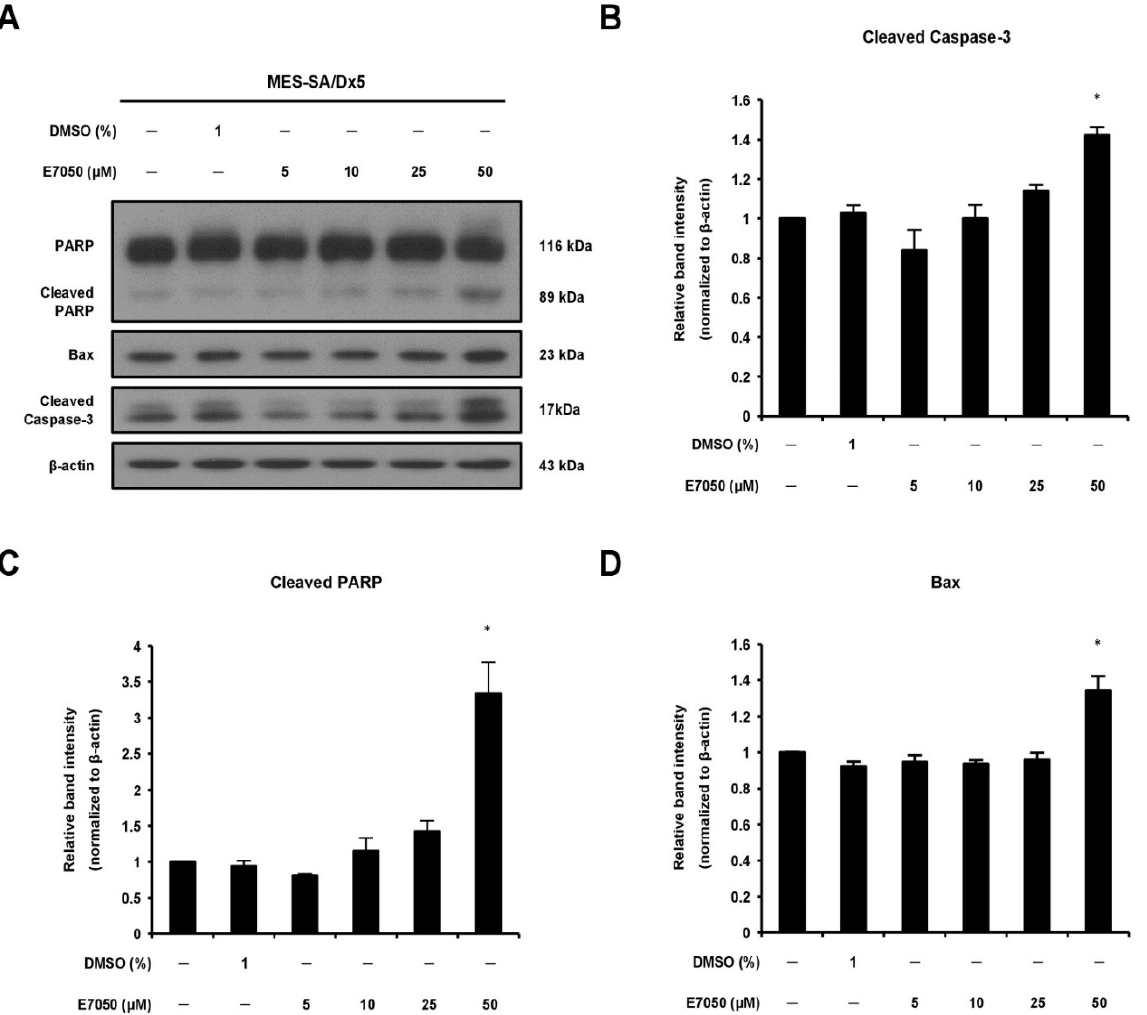
Figure 2. Effects of E7050 on the expression of apoptosis-related proteins in MES-SA/Dx5 cells. ( A ) Cells were treated with E7050 at various concentrations (5–50 µM) for 24 h. Cellular extracts were prepared and subjected to Western blotting with specific antibodies which recognized PARP, cleaved PARP, cleaved caspase-3, Bax and β -actin. β -actin was used as an internal loading control. The relative protein levels of ( B ) cleaved caspase-3, ( C ) cleaved PARP and ( D ) Bax were quantified by densitometry and normalized to β -actin. Data are presented as the mean ± SEM of three independent experiments. * p < 0.05 versus vehicle-treated control